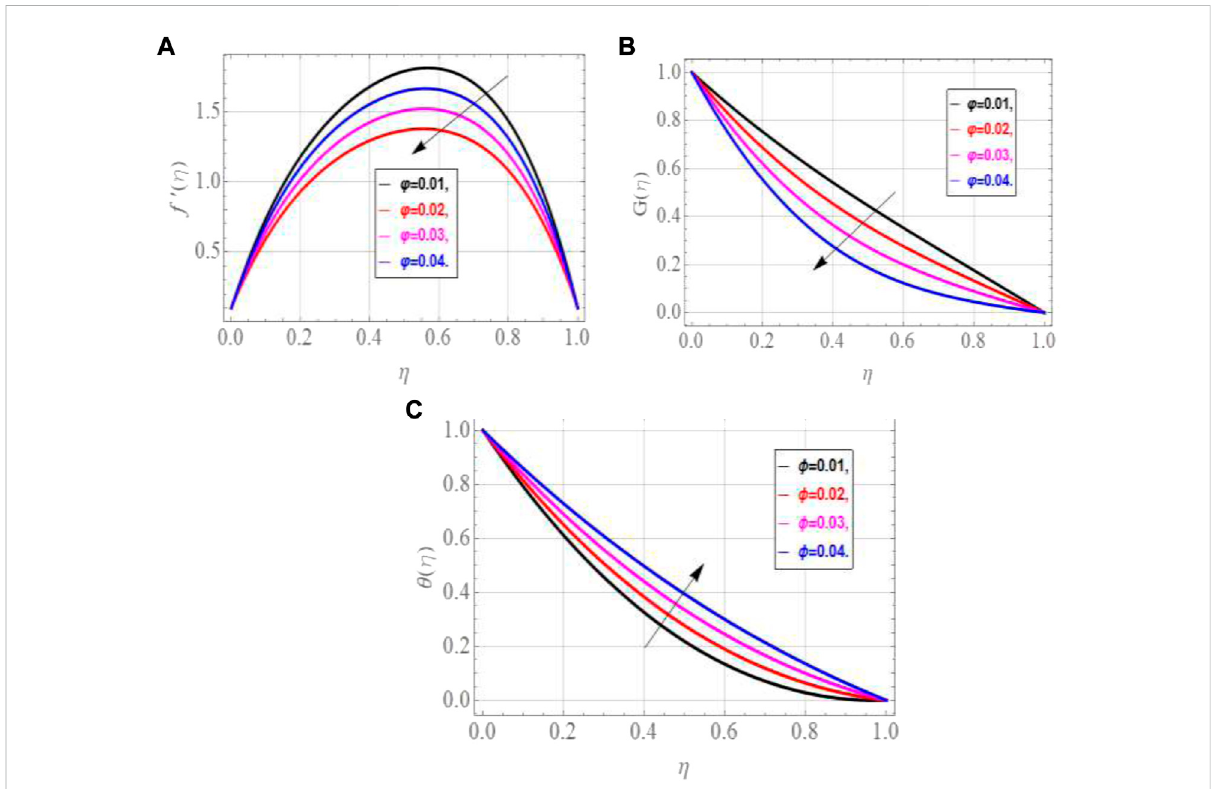
FIGURE 4 Impact of ϕ on f ′ ( η ) , G ( η ) , θ ( η ) .